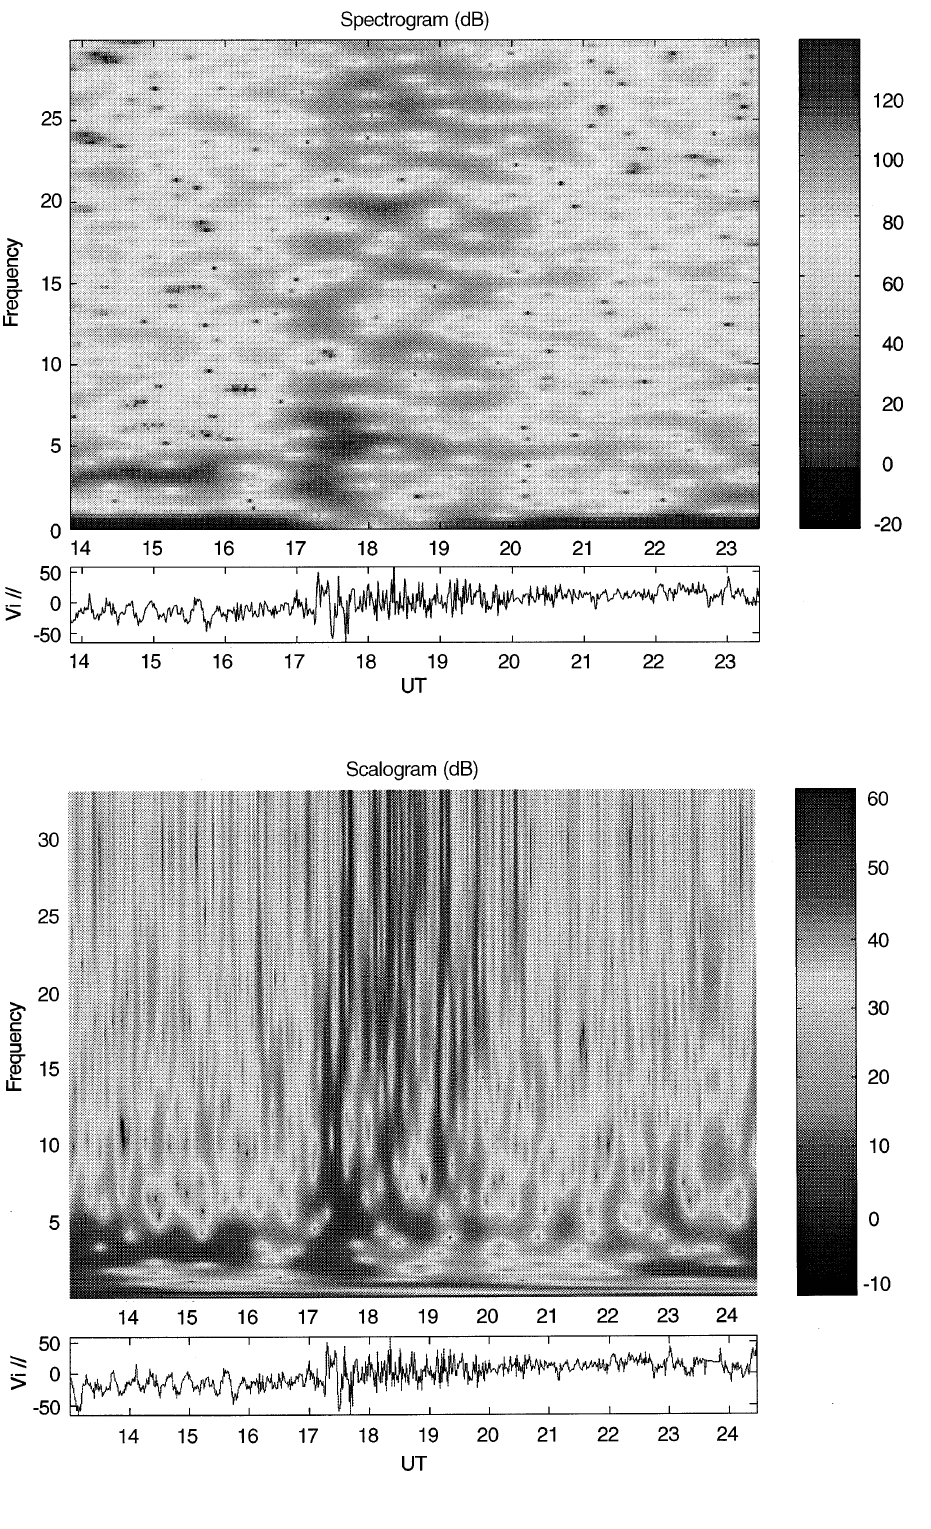
Fig. 12. Scalogram of the ion velocity; frequencies are in h